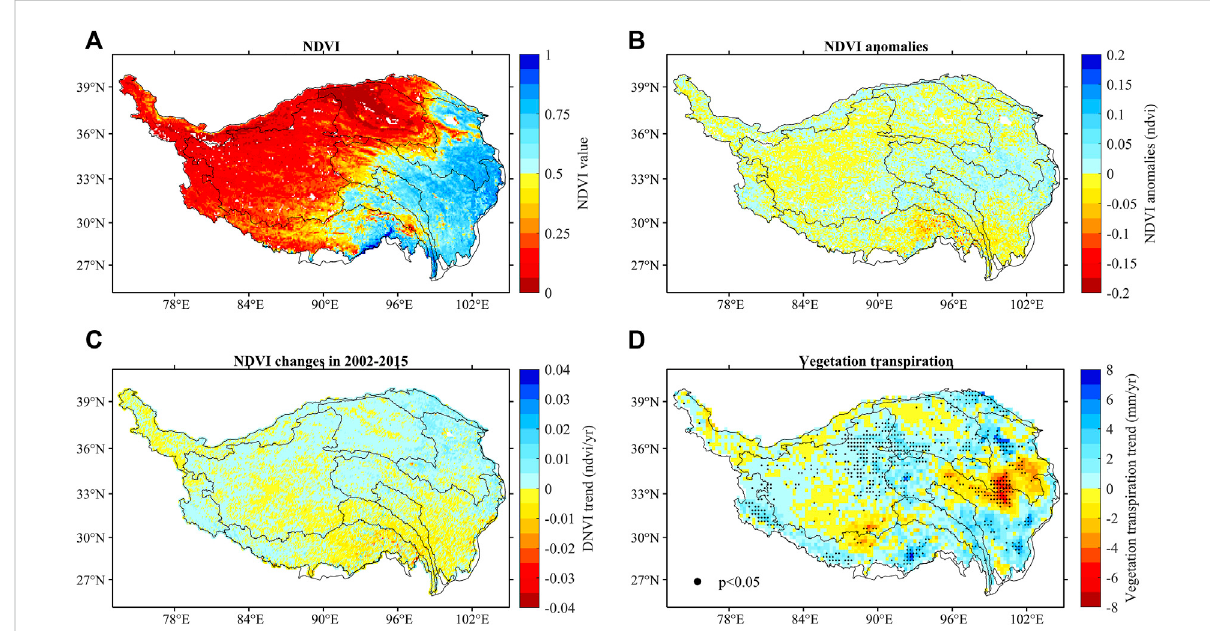
FIGURE 9 ThechangesinvegetationindexandvegetationtranspirationontheTibetanPlateaubetween2002and2015. (A) anannualaverageofNDVI; (B) an annual average of anomalies of NDVI are based on 2004 – 2009, with a similar base period for TWSA anomalies; (C) NDVI changes during 2002 – 2015; and (D) vegetation transpiration trends from 2002 to